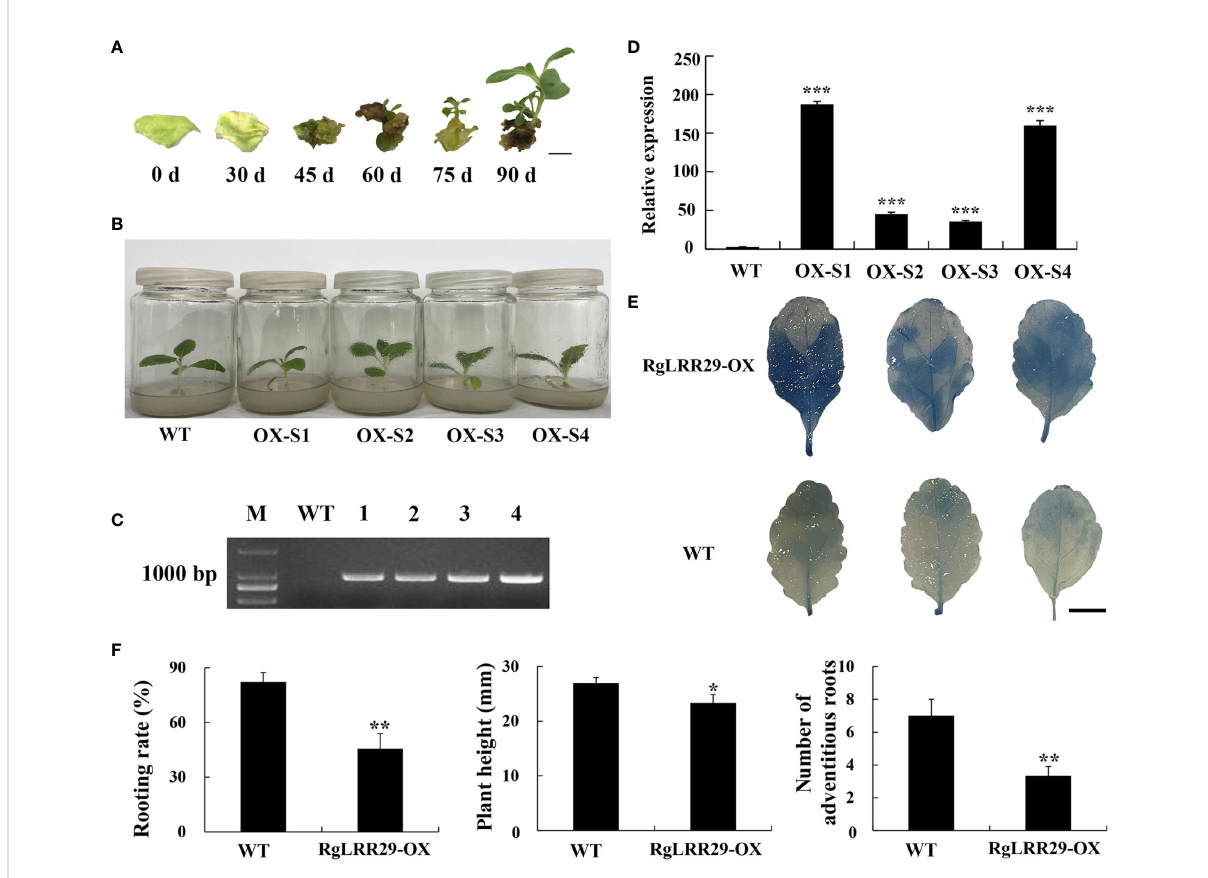
FIGURE 7 Con fi rmation of positive RgLRR29 -overpression Rehmannia glutinosa . (A) Regeneration process of RgLRR29 -overexpression R. glutinosa plants. Bar = 1cm; (B) Morphology of RgLRR29 -overexpression R. glutinosa plants cultured in MS medium for three weeks. OX-S1, OX-S2, OX-S3, and OX-S4 represent different lines of RgLRR29 -overexpression R. glutinosa plants. Wild-type (WT) plants of the same age are shown as the control; (C) PCR products for the positive screening of transgenic lines; Lanes M and WT represented the DL2000 size marker and WT plants, respectively; Lanes 1 – 4 represented RgLRR29 -overexpression lines 1 to 4, respectively; (D) Expression patterns of different RgLRR29 - overexpression lines (OX-S1, OX-S2, OX-S3, OX-S4) in roots. The error bars represent the standard error (n = 3) (***: p < 0.001); (E) ROS accumulation in RgLRR29 -overexpression and WT R. glutinosa plants. Trypan blue staining was used to detect ROS accumulation in the leaves of 2-week-old RgLRR29 -overexpression and WT R. glutinosa plants; (F) The rooting rate, Plant height and the number of adventitious roots of WT and RgLRR29 -overexpression R. glutinosa plants. The rooting rate was calculated from three independent experiments. More than 15 plants were subjected to root induction each time. Other data are shown for one representative result of three independent experiments; the results are shown as the average ± SE (n = 5). * P < 0.05 and **P < 0.01 indicate signi fi cant differences based on the